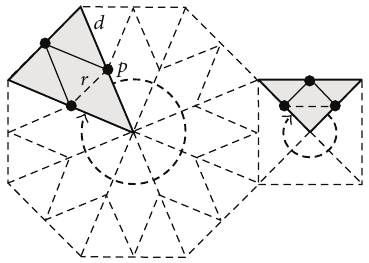
Figure 14: Radius control diagram (Type B).